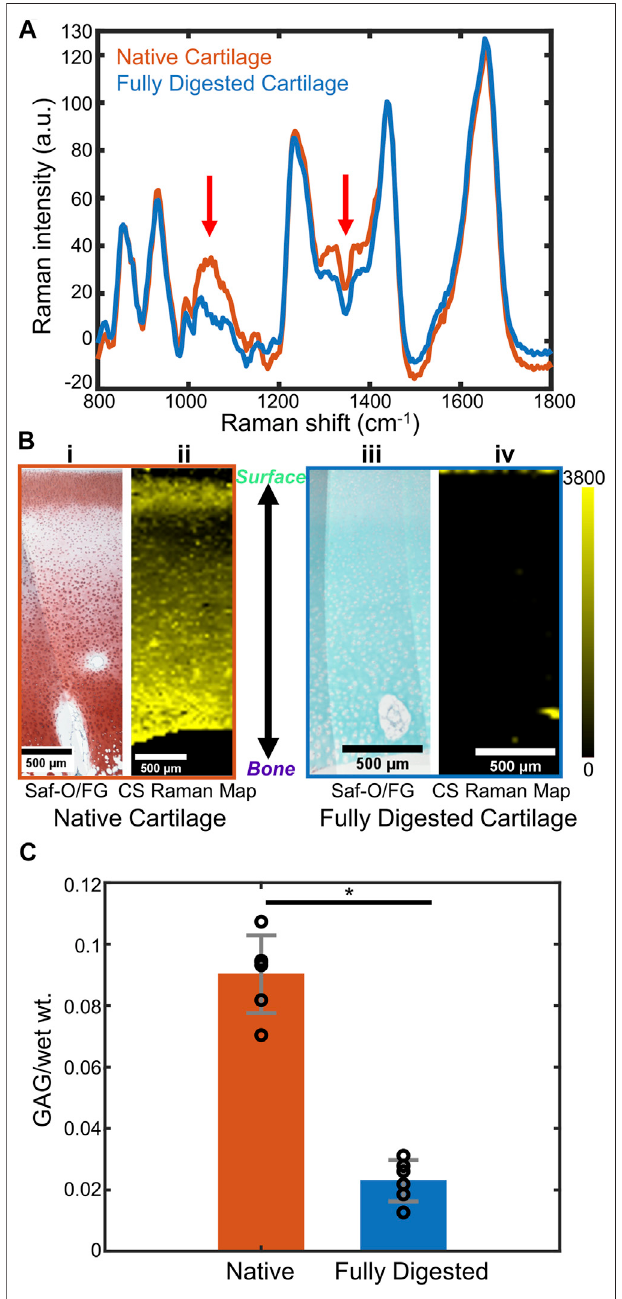
FIGURE2|(A) RepresentativeRamanspectraofnativebovinecartilage and fullytrypsin-digestedbovinecartilage.(Spectra areobtainedbyaveraging a 15-pixel by 15-pixel area at the center ofthe respective Raman images. Red arrows: GAG-related spectral regions). (B) (i) Safranin-O stained histology section of native cartilage, articular surface at the top of the image. (ii) CS coef fi cient map for the same region as (i) . (iii) Safranin-O stained histology section of fully trypsin-digested cartilage, articular surface at the top of the image. (iv) CS coef fi cient map for the same region as (iii) . (C) DMMB biochemical assay to determine the GAG content (GAG/wet wt.) of native cartilage and fully digested cartilage ( n (cid:2) 6, *: p < 0.01). Abbreviations: Saf-O, Safranin-O; FG, Fast Green; CS, chondroitin